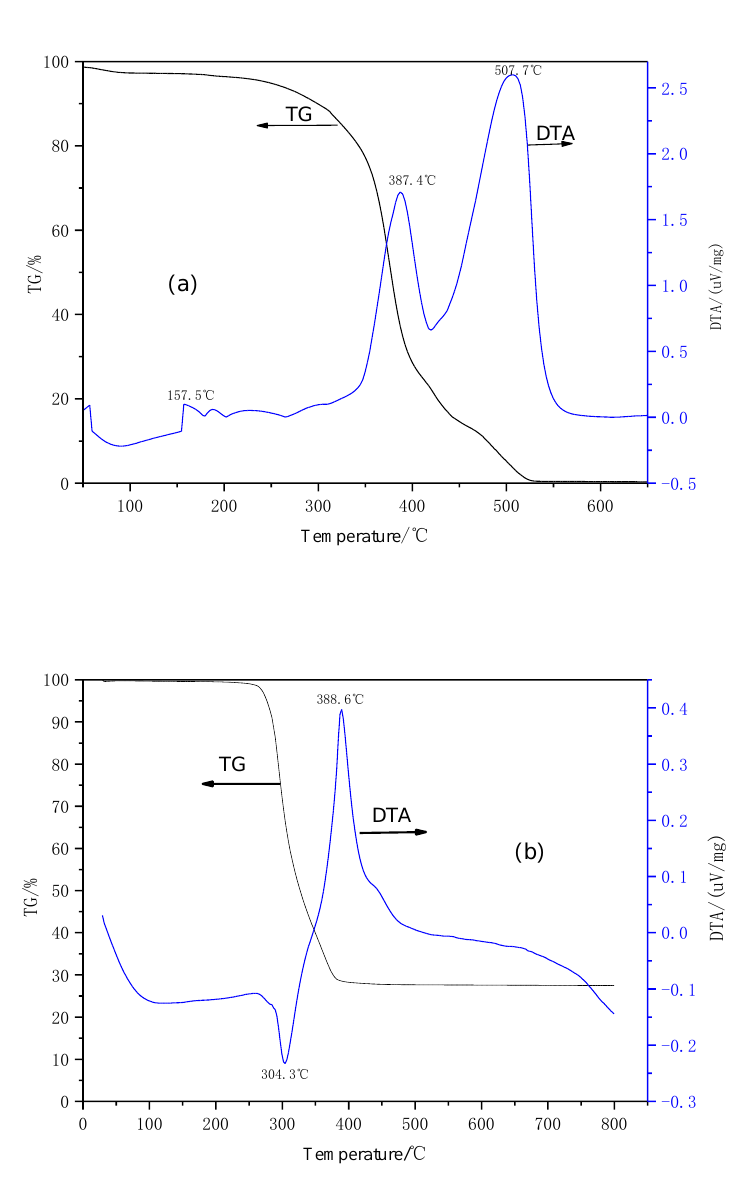
Figure 6. DTA/TG analysis of water transfer paper ( a ) and PVB paper ( b ).